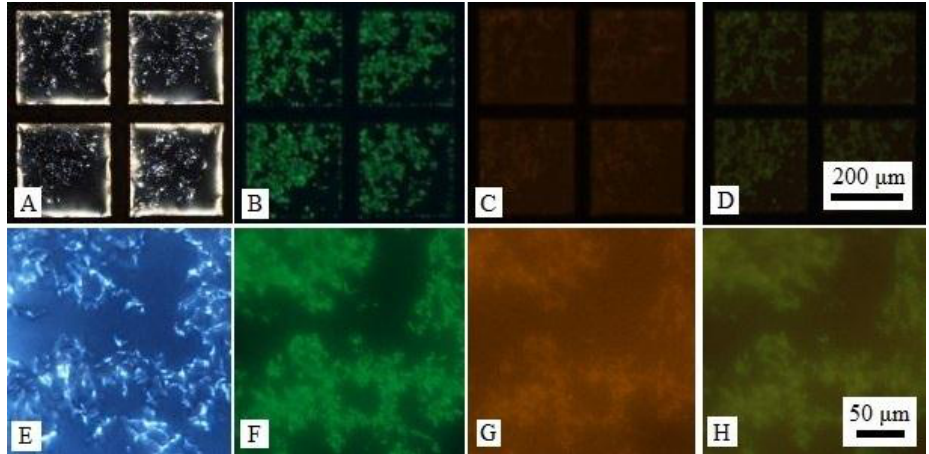
Figure 2. ( A ) Optical images (crossed polars) and ( B ) corresponding green fluorescence micrographs and ( C ) corresponding red fluorescence micrographs of LC-aqueous interface exposure to a mixture of 20 μM DNA-lipids, 5 μM L -DLPC and 0.5 μM Rh-DHPE for 1 h then introduction of 1× SYBR Green; ( D ) Overlaid images of ( B , C ); ( E – G ) Magnified image of ( A – C ); ( H ) Overlaid images of ( F , G ).